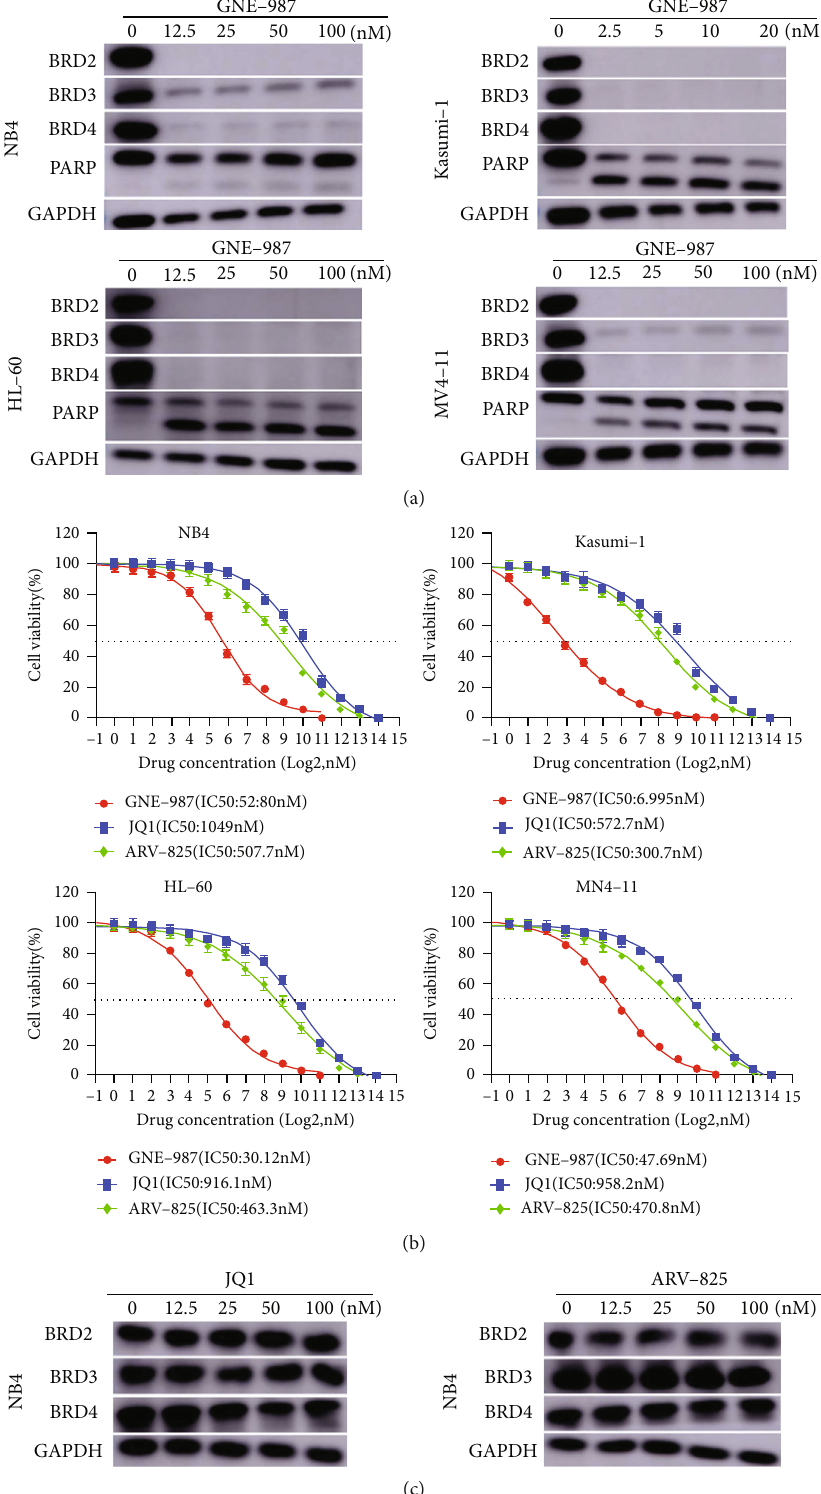
Figure 4: GNE-987 inhibits the expression of BET protein in AML cells and increases the expression of PARP protein, and the e ff ect is far better than those of JQ1 and ARV-825. (a) Western blotting analysis showed that GNE-987 induced BET protein degradation, and PARP increases in NB4, Kasumi-1, HL-60, and MV4-11 cell lines. (b) Drug sensitivity assay of NB4, Kasumi-1, HL-60, and MV4-11 cell lines after treatment with gradient concentrations of GNE-987, JQ1, and ARV-825 for 24 h. (c) After adding JQ1 and ARV-825 at the highest concentration of 100nM, the degradation e ffi ciency of BET protein is much lower than that of